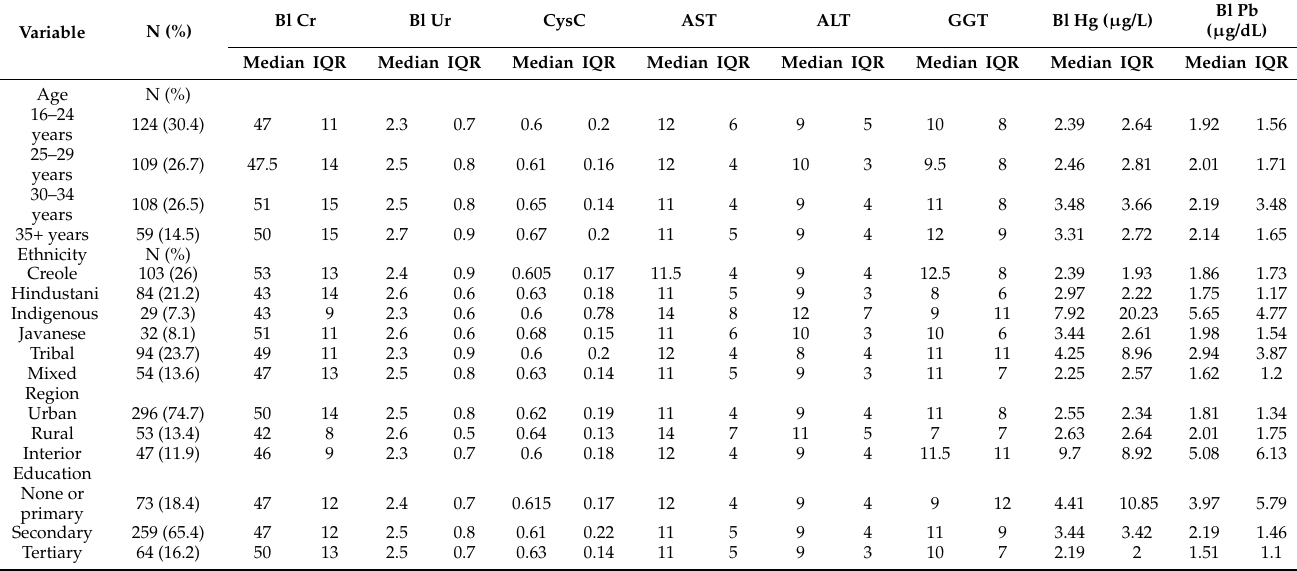
Table 1. Concentrations of biomarkers of liver and kidney function are presented, as are concentra- tions of lead and mercury in blood samples from the participants in various categories. Data are presented as medians with interquartile ranges (IQR).